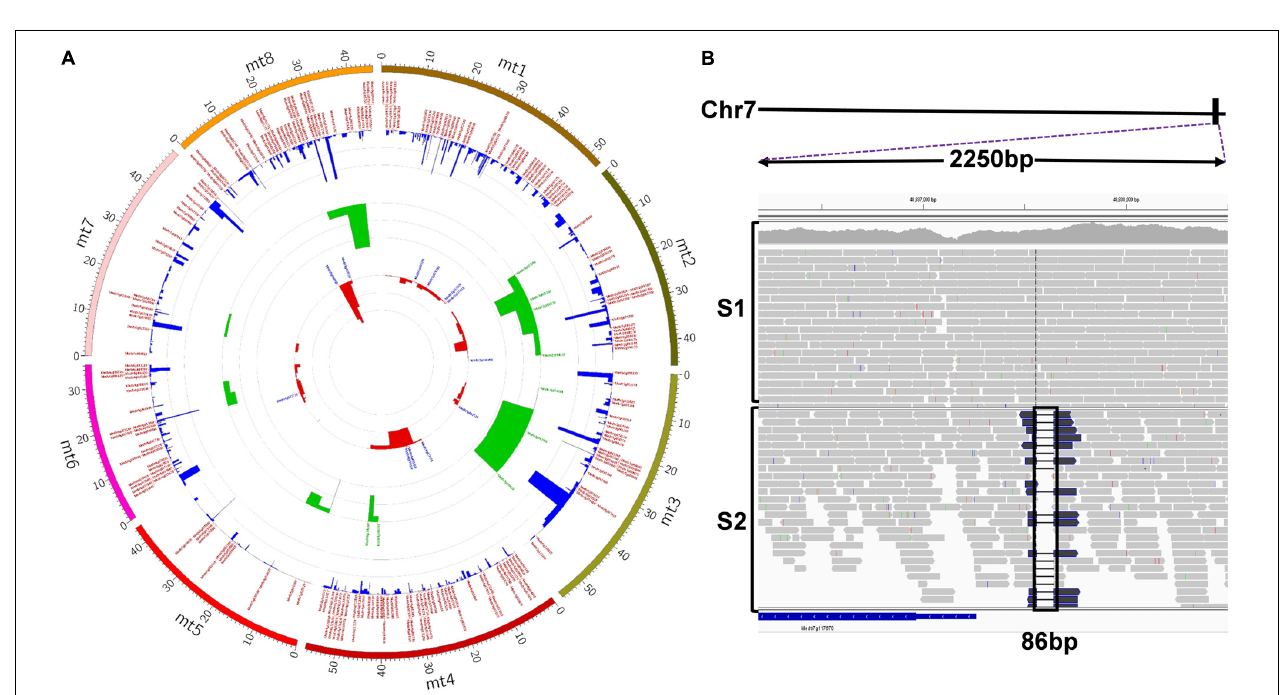
FIGURE 5 | (A) Circos visualization of identified deletions in S2. The inner-most circle (red) represents deletions > 1kb; the middle circle (green) represents deletions between 100 bp and 1 kb; the out-most circle (blue) represents deletions < = 100 bp. Each circle was annotated by gene IDs if deletions contain or are in genes (high-resolution image link: https://github.com/noble-research-institute/fnbtools/blob/master/example/Circos_S2_deletion.png). (B) Visualization of the causal deletion using IGV. The deletion is located at the bottom of chromosome 7 (solid black rectangular box). A 2250 base pair window from IGV, as indicated by the purple dotted lines, shows the reads around the deletion. The histogram plot illustrates the read depth with individual reads plotted below. There is no deletion in the control sample S1. Black box highlights the 86bp deletion region in the mutant sample S2.